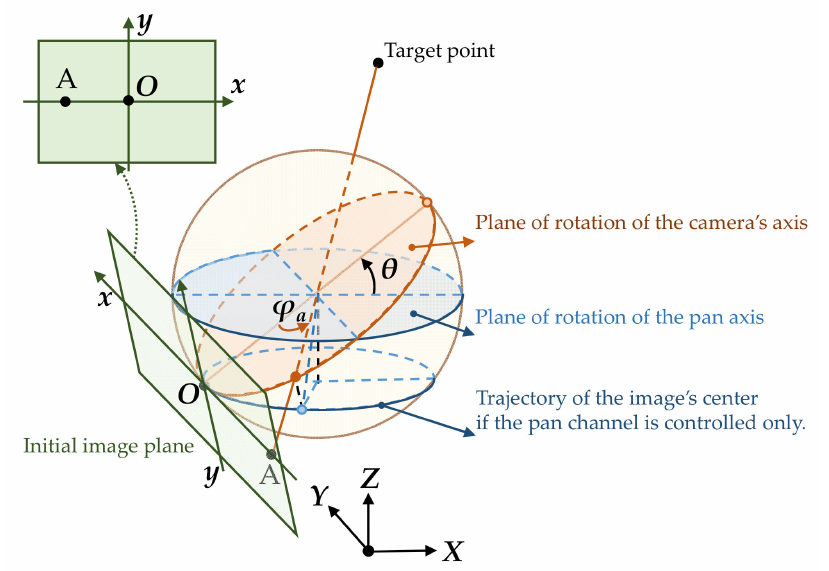
Figure 3. Relationship between gimbal orientations and location of the target’s projection on the image